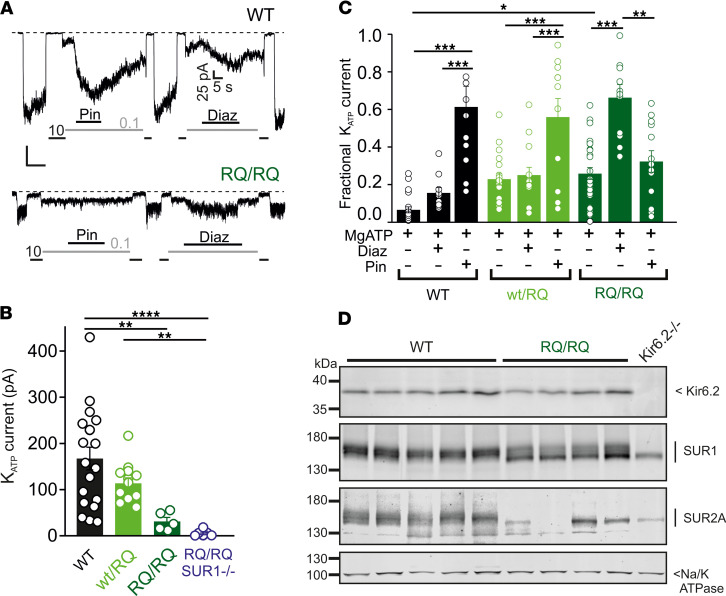
Decreased KATP channel density and switch to SUR1 dependence in SUR2A[R1154Q] hearts.(A) Representative inside-out patch clamp recordings of KATP channel activity from acutely dissociated ventricular myocytes from WT and SUR2RQ/RQ mice. Inhibition by 10 or 0.1 μM MgATP and the response to the K channel openers pinacidil and diazoxide (Diaz) at 100 μM, in the presence of MgATP (recording at –50 mV membrane potential), are shown. (B) Absolute KATP current level in zero ATP, from experiments as in A. (C) KATP current, as a fraction of current in zero ATP, from experiments as in A. (D) Western blot analysis of the membrane fraction from ventricular heart tissue of WT and SUR2RQ/RQ mice (4 biological replicates each) showing protein steady-state levels of KATP channel subunits and Na/K-ATPase α subunits. Since both SUR subunits are only core-glycosylated when the Kir6.2 subunit is missing (28), tissue from a single Kir6.2–/– mouse is also shown for reference. Statistical significance was determined by 1-way ANOVA followed by Tukey’s test for pairwise comparison; * P < 0.05, ** P < 0.01, *** P < 0.001.